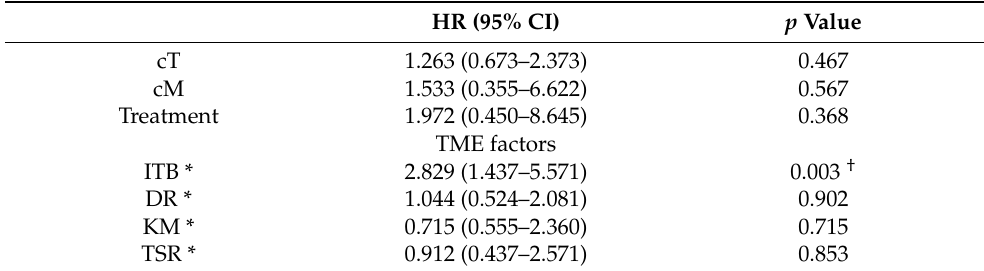
Table 3. Multivariate Cox proportional hazards analysis of predictors for